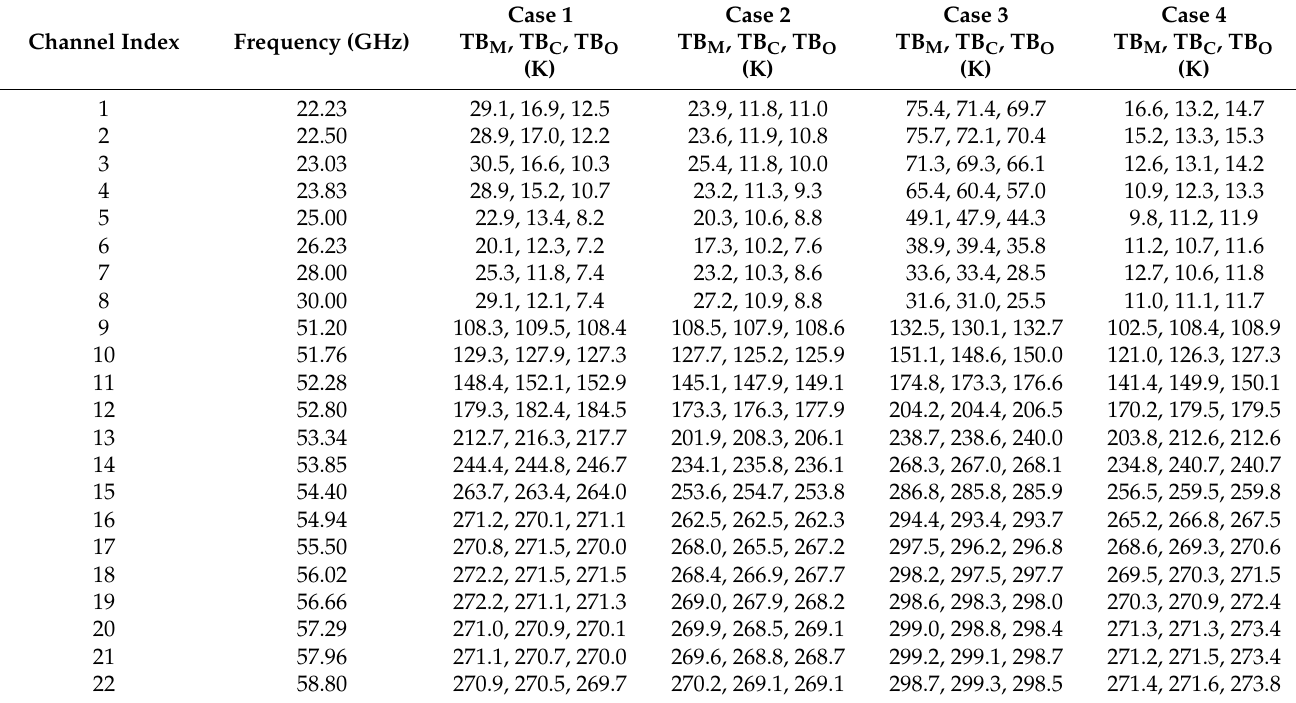
Table 1. The radiometer channel frequency used for atmospheric temperature and humidity and a comparison of brightness temperatures before and after